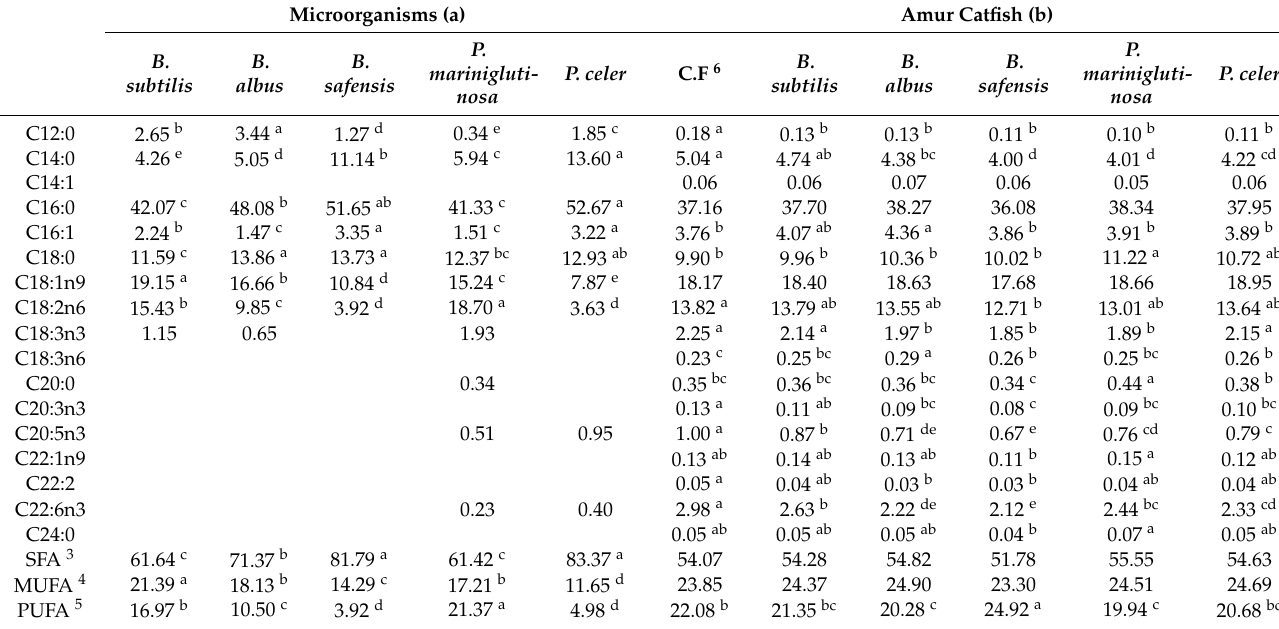
Table 4. Fatty acid compositions of bacterial strains and Amur catfish fed with commercial feed and 5% freeze-dried bacteria biomass-supplemented feed at end of 8-week experiment (%) 1,2